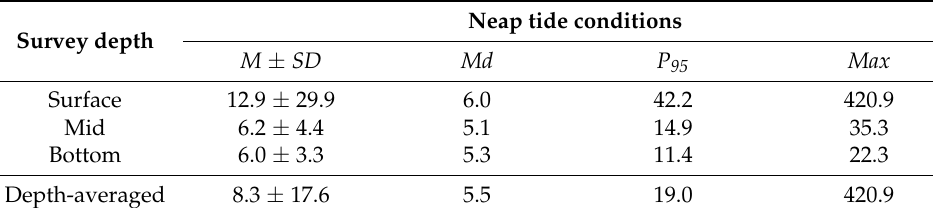
Table 3. Depth compartment and depth-averaged ( M ) ± standard deviation ( SD ), median ( Md ), 95th percentile ( P 95 ), and maximum ( Max ) volumetric concentrations [ µ L L − 1 ] during neap, transitional, and spring tide conditions based on all sample